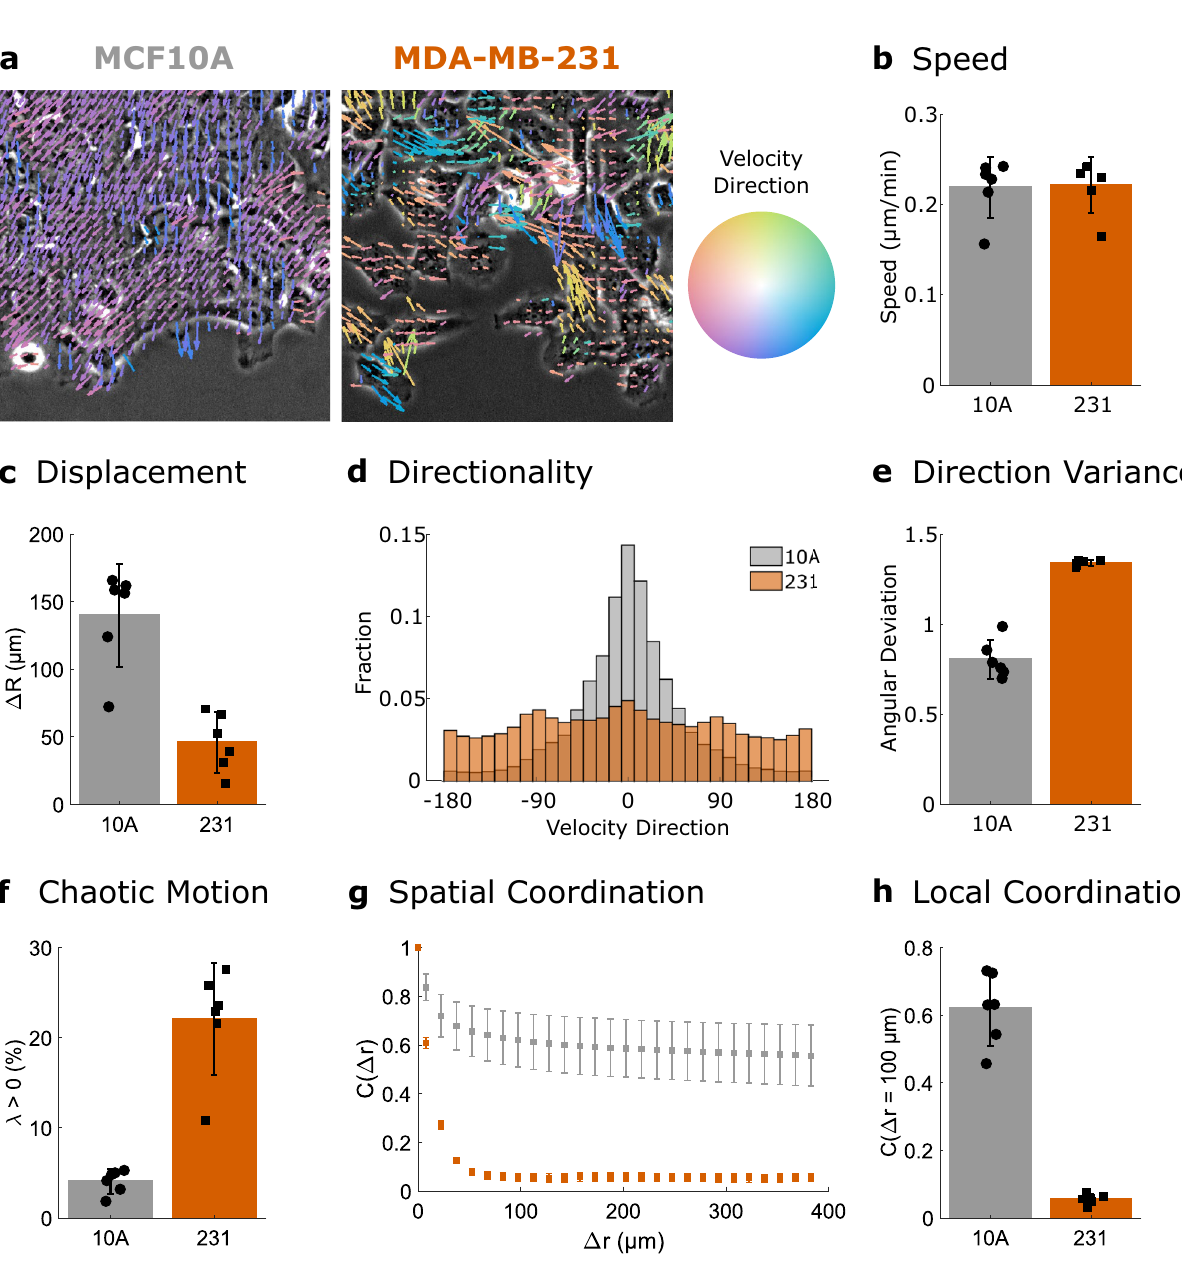
Figure 2. Collective behavior quantitatively decreases in metastatic cells. ( a ) PIV flow vectors colored by motion direction and overlaid on images of MCF10A cells (left) and MDA-MB-231 cells (right). ( b ) Mean speed of the PIV flow field. ( c ) Displacement of the leading edge. ( d ) Cumulative distribution across replicates of velocity direction. ( e ) Variability in velocity direction quantified by angular deviation. ( f ) Chaotic motion quantified by the percentage of positive finite-time Lyapunov exponents (λ). ( g ) Spatial coordination across length scales quantified by the autocorrelation of radial velocity. ( h ) Local coordination is defined as the correlation value at 100 µm (a few cell lengths). N = 6 independent experiments. Error bars indicate 95% confidence